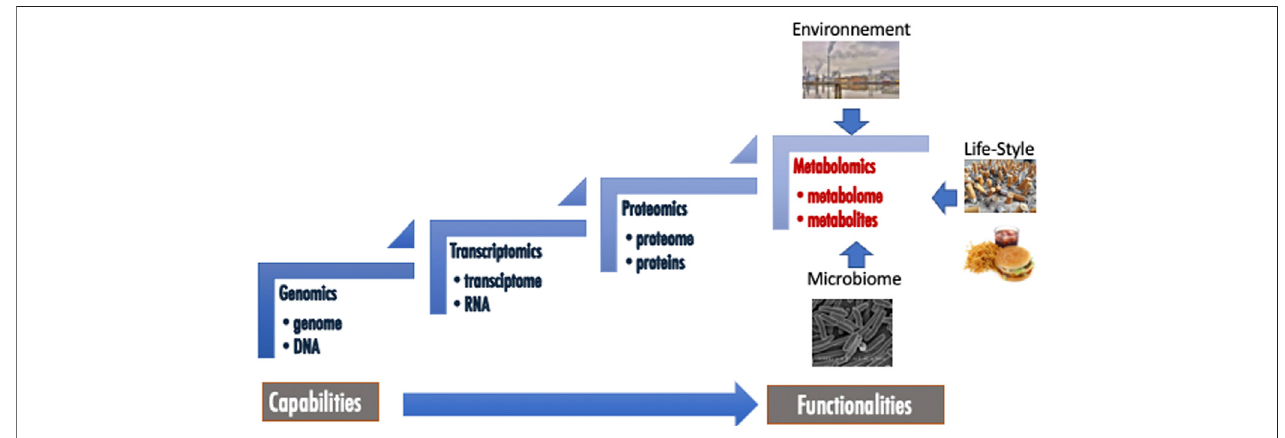
FIGURE 1 | Metabolomics in the fi eld of other